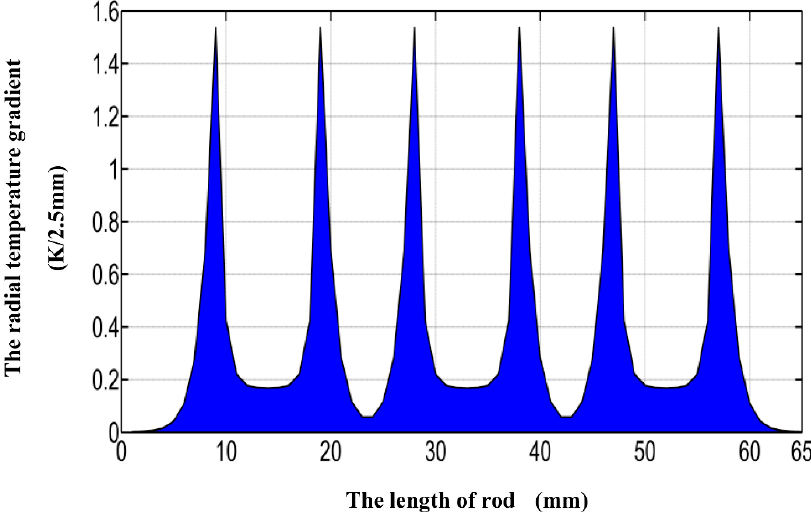
Figure 8. The radial temperature gradient as a function of the length of the rod.